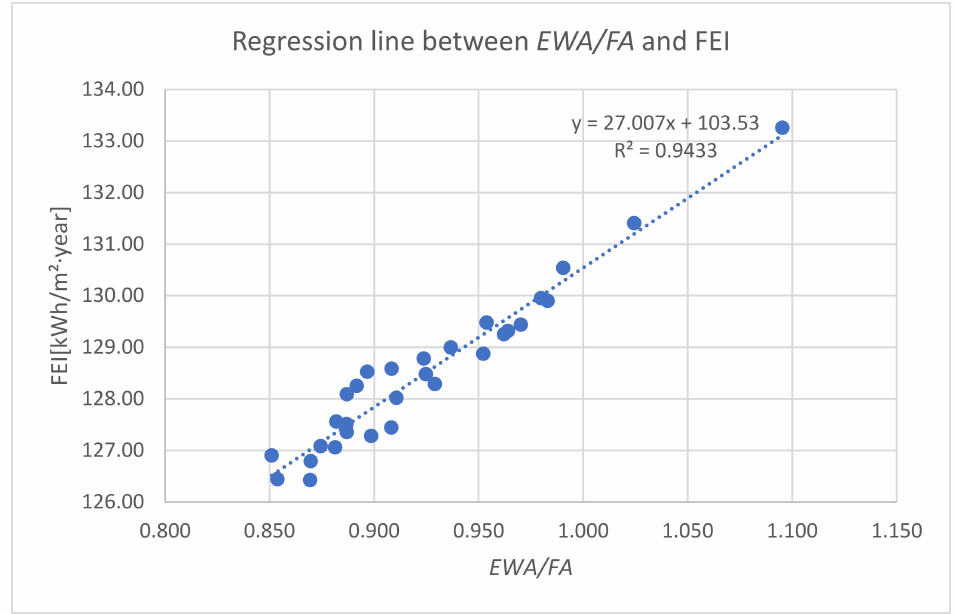
Figure 5. High degree of regression line fit as an approximation of the linear dependence of the FEI dependent variable on the independent EWA / FA variable.